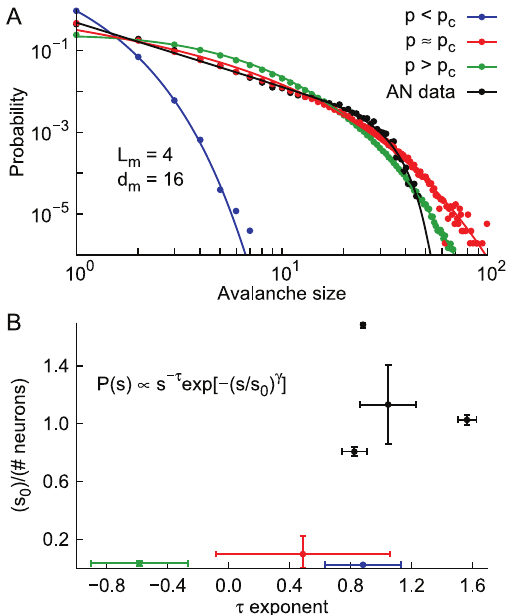
Figure 6. Size distributions for anesthetized animals and undersampled models. A) Avalanche size distributions for the model (subcritical blue, critical red and supercritical green) and an anesthe- tized rat (black). The MEA employed is the same for all cases ( L m ~ 4 , d m ~ 16 ). Temporal bins calculated from mean inter-event interval in all cases. Lines represent the best fit of a power law with a sharp cutoff. B) Parameters fitted for each of the model distributions showed in panel A, together with experimental distributions from 4 anesthetized rats. Error bars indicate standard deviation for the values.